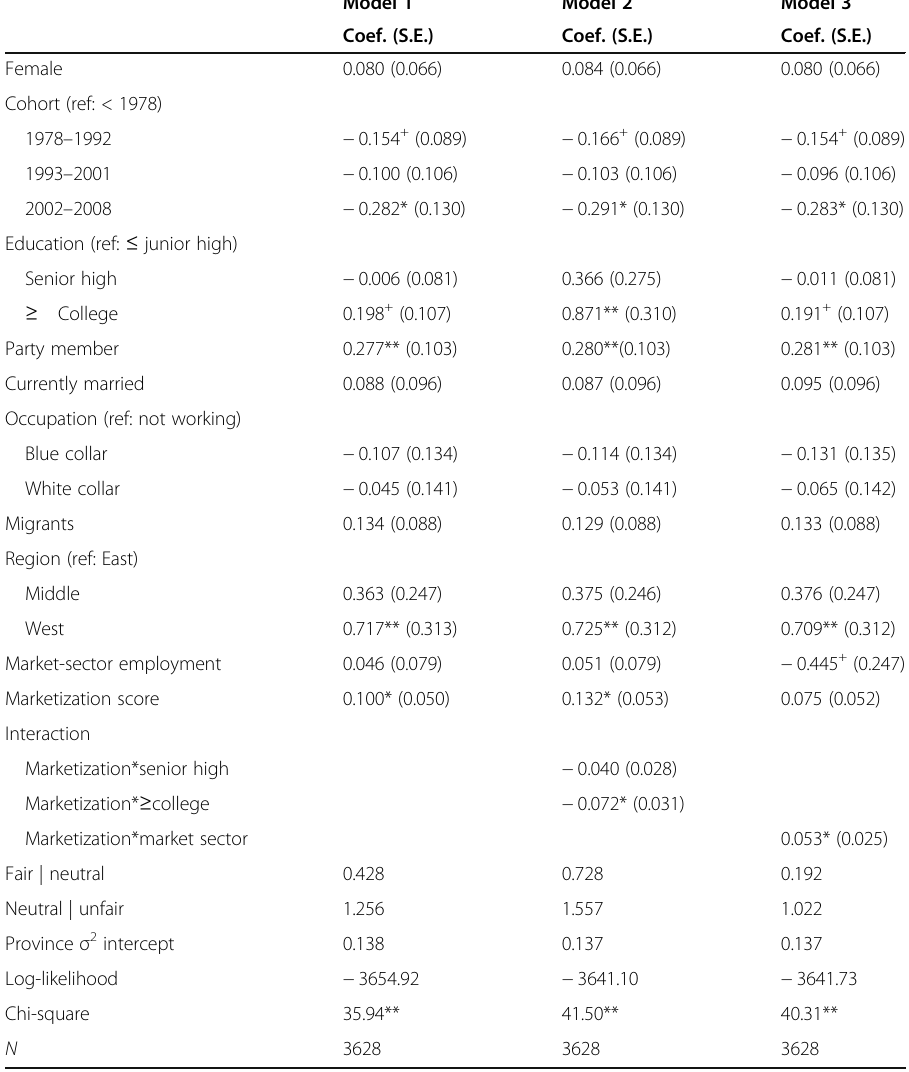
Table 2 Coefficients from multi-level ordinal logistic regressions predicting viewing guanxi as fair, neutral, or unfair (Chinese General Social Survey